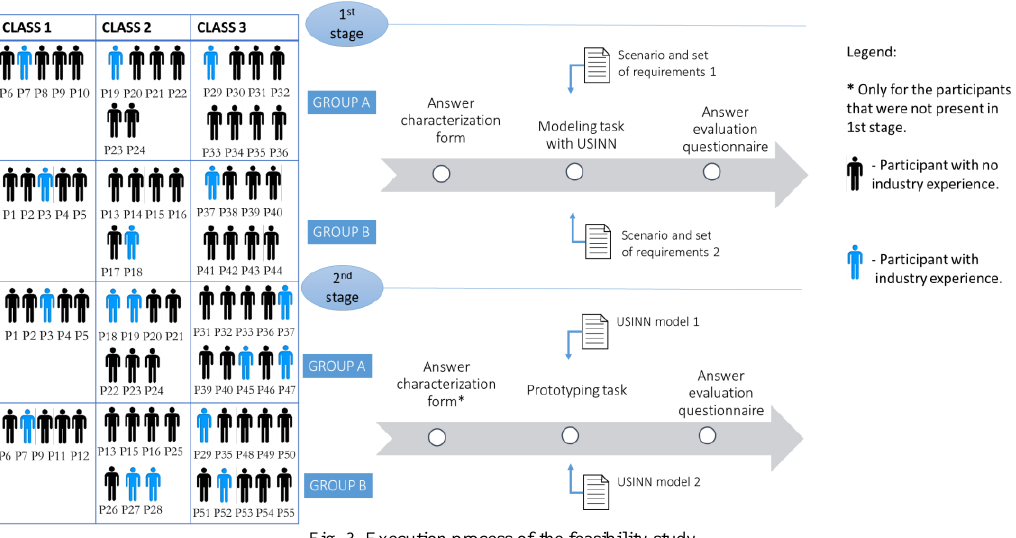
Fig. 3. Execution process of the feasibility study.